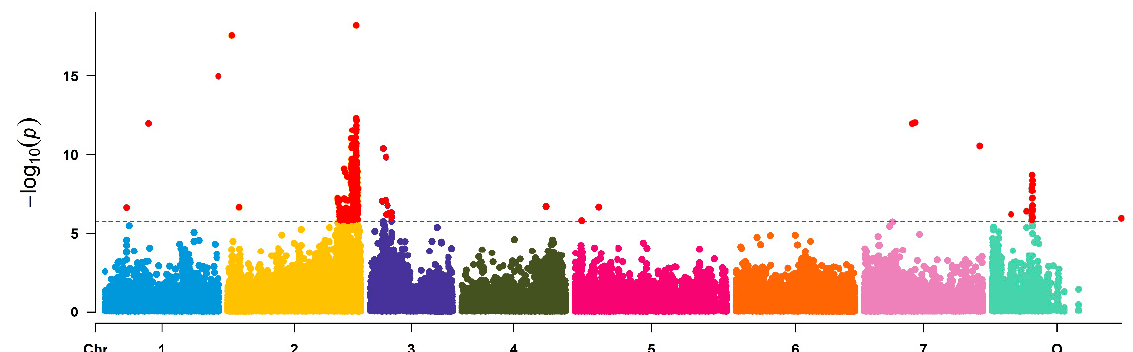
Figure 8. Manhattan plot of associations between 63,000 SNP markers and fragrance in a set of 95 garden roses. For a better view of the clusters, the y -axis was scaled only to 1 × 10 − 20 . Supplementary Figure S3 displays the full Manhattan plot including the outlier markers. The x -axis represents the chromosomes of Rosa chinensis , including chromosome 0 with contigs not assigned to a precise location to date. Associations were calculated in Tassel 3.0 using MLM, including population structure (Q) and kinship (K), and box Cox transformed fragrance data. The red dotted line indicates the Bonferroni corrected level of significance (-log10 = 5.75).